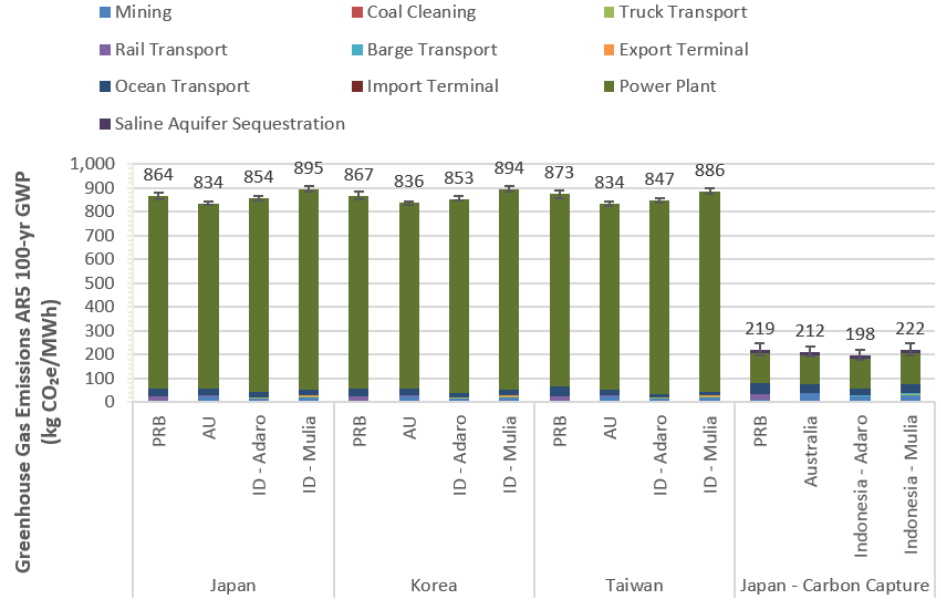
Figure 2. Cradle-to-busbar GHG emissions for U.S. (PRB), Australian (AU), and Indonesian (ID) coals exported to Japan, South Korea (Korea), and Taiwan, with and without 90% CCS.